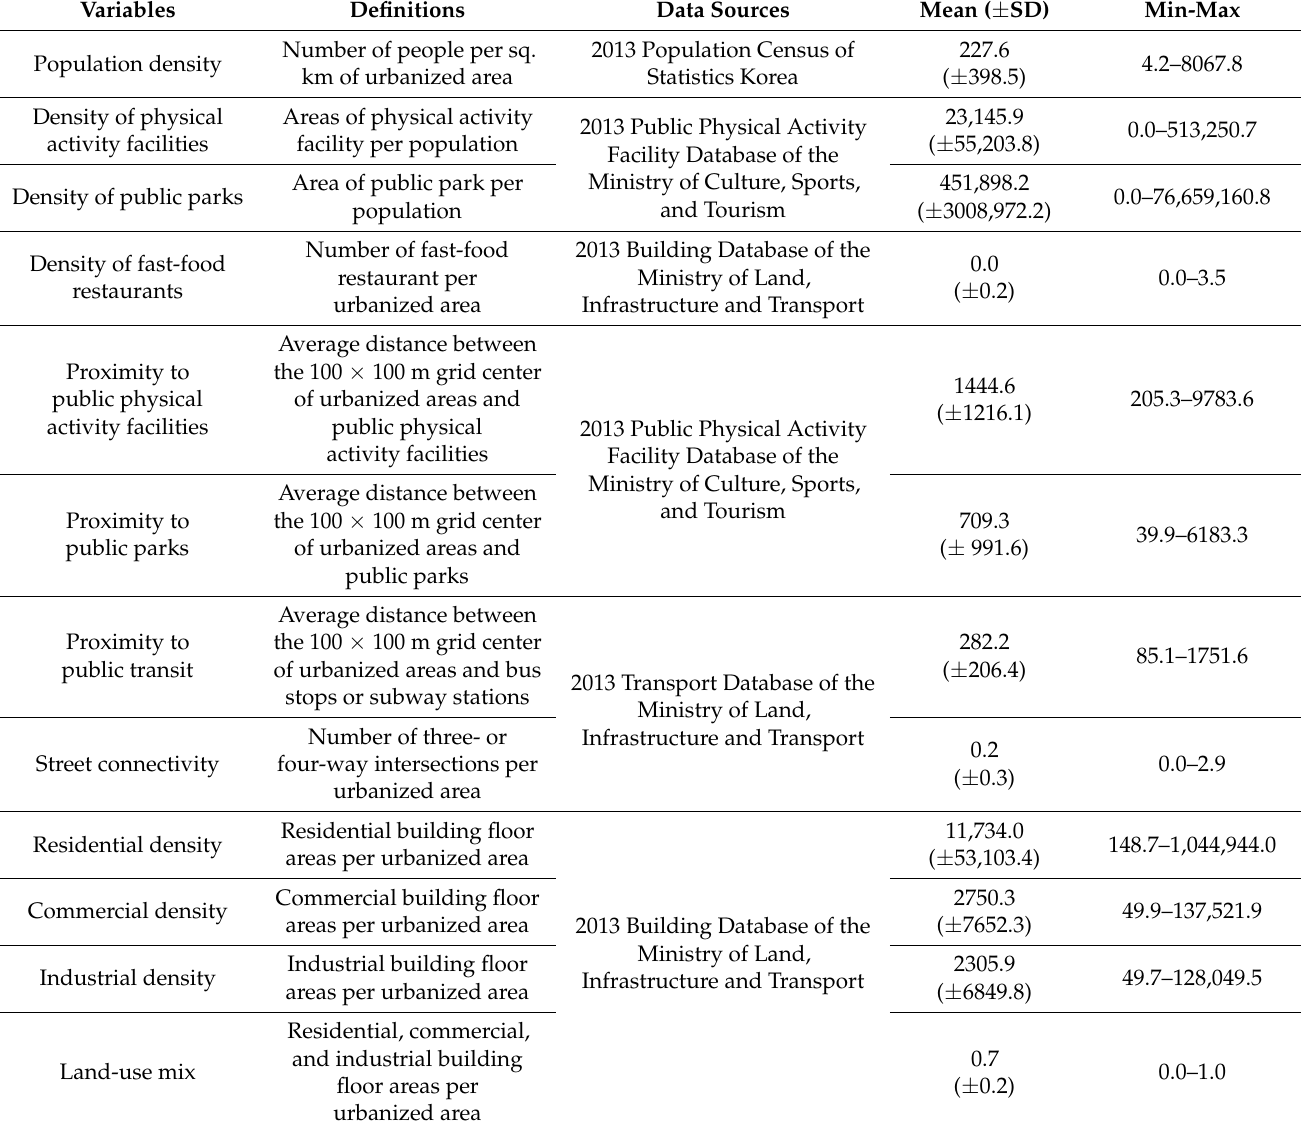
Table 1. The objectively measured built